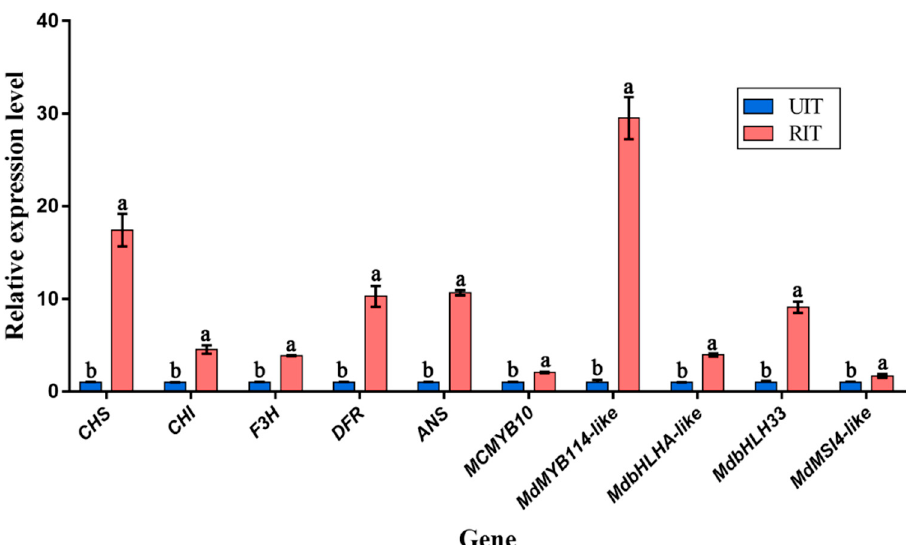
Figure 10. RT-PCR analysis of 11 DEGs related to anthocyanin biosynthesis in M . ‘Profusion’. The data show mean values ± SD of three biological replicates. The di ff erent letters represent significant di ff erences between UIT and RIT, as judged by the paired t -test ( p < 0.05). 18S rRNA (DQ341382) was used as an internal reference gene for qRT-PCR data normalization, and the relative expression level of each gene in UIT was set to 1.